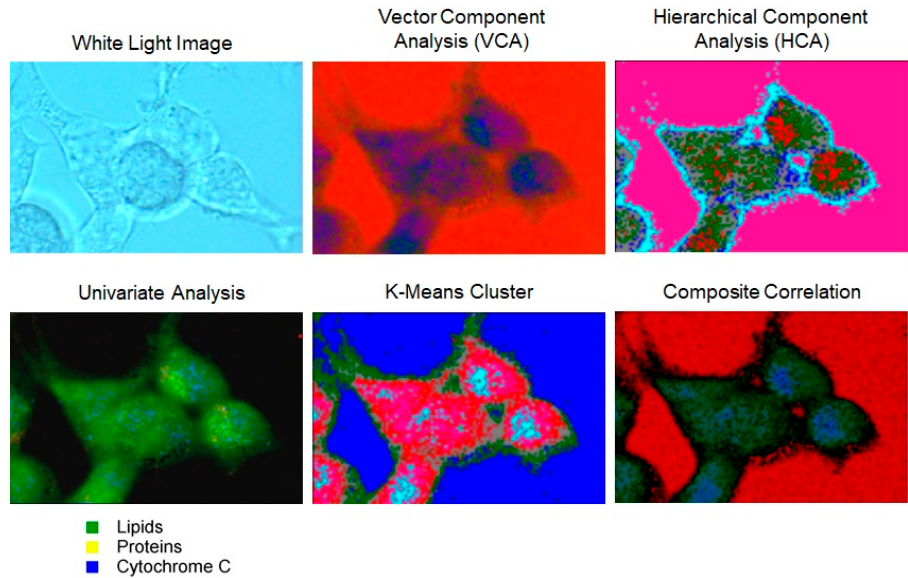
Figure 8. Raman images of live HEK cells were generated using univariate and multivariate methods available in CytoSpec software package and show lipids, proteins, and cytochrome C constituents using different colors. Despite the color schemes varying from one method to another, the images manifest the regions corresponding to the three main constituents. Measurement parameters: 60 × WI objective, 10 mW of the 532 nm laser power at the sample, 25 µ m confocal pinhole, 0.5 µ m image pixel, 1120 spectra, 15 min total collect time.